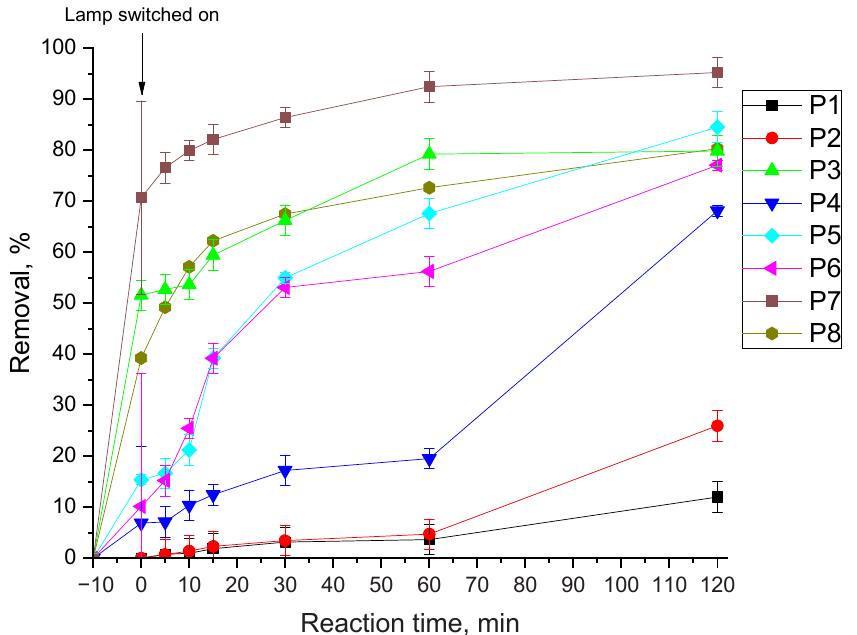
Figure 5. Removal of ampicillin from water solution using a blue LED (445–465 nm) as irradiation source.